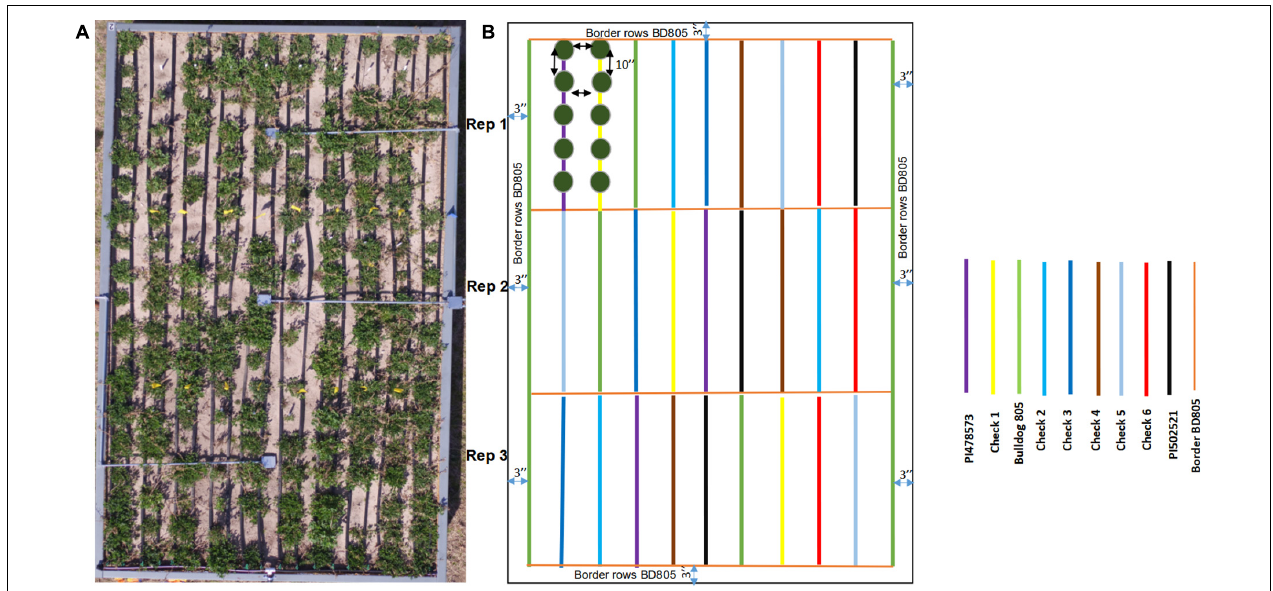
FIGURE 5 | The raised bed experimental plot to study alfalfa response to rainfed treatment. (A) Actual plot (Bed 1) to show the details of spaced planting of three alfalfas evaluated in the study along with six check cultivars. (B) Field design to explain the spacing, randomization, and replication details. The genotypes and the checks evaluated are color-coded on the